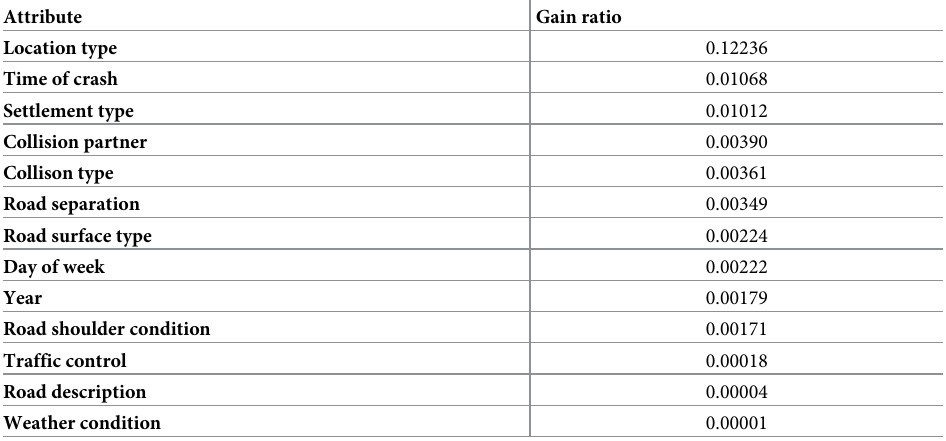
Table 5. Gain ratio of each